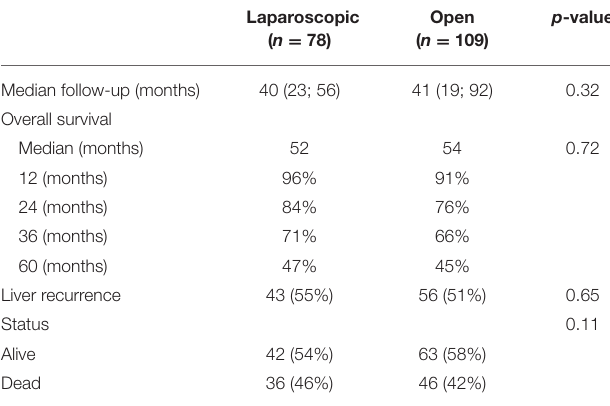
TABLE 3 | Short- and long-term